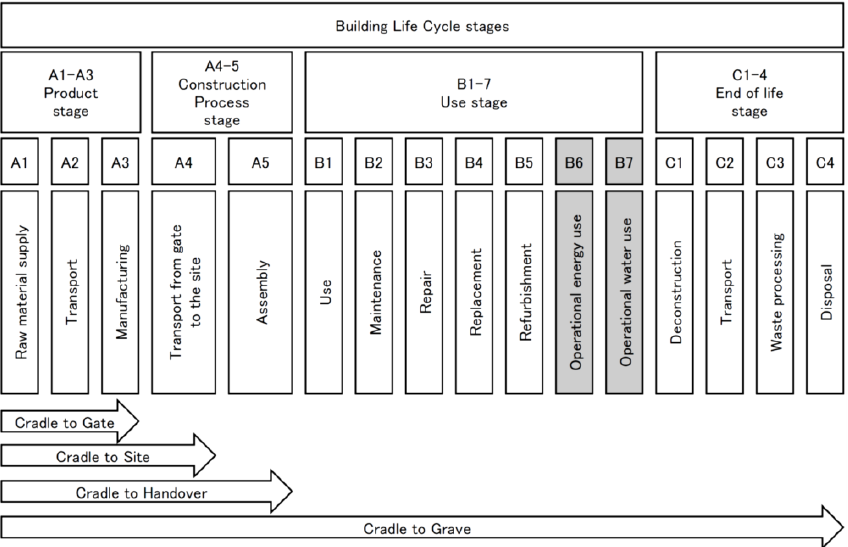
Figure 1. Proposed model for system boundaries [2].